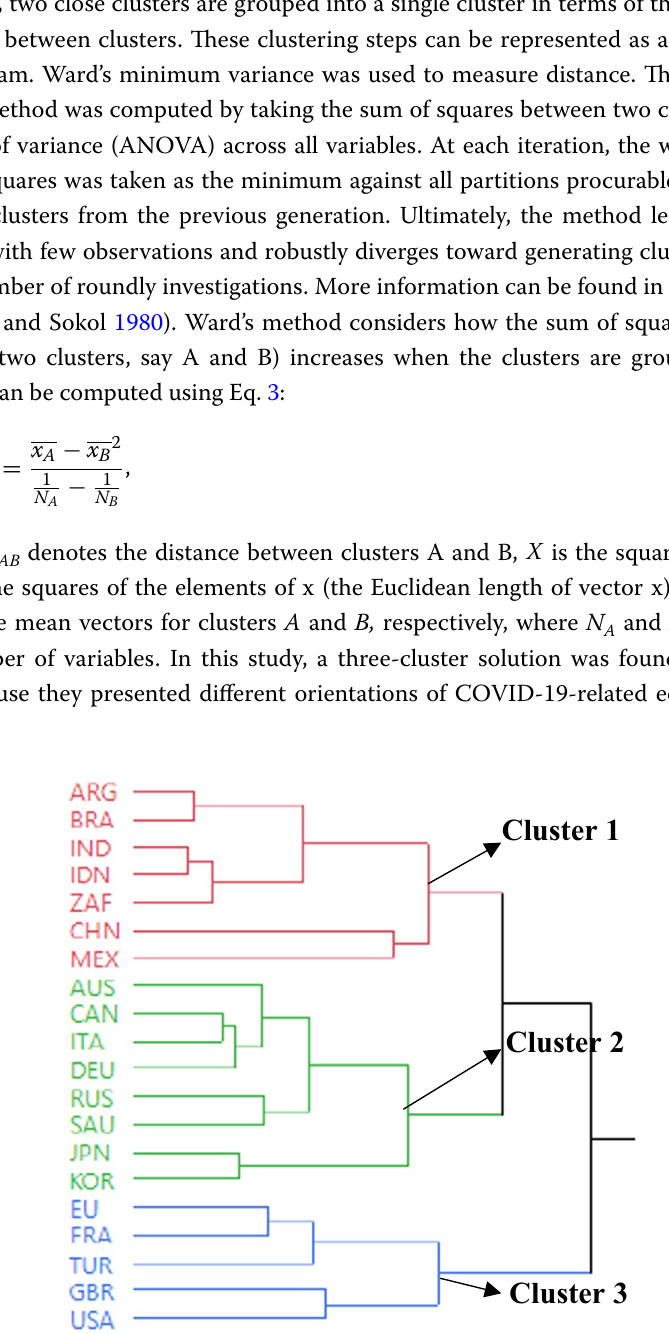
Fig. 3 Dendrogram plot for clustering G20